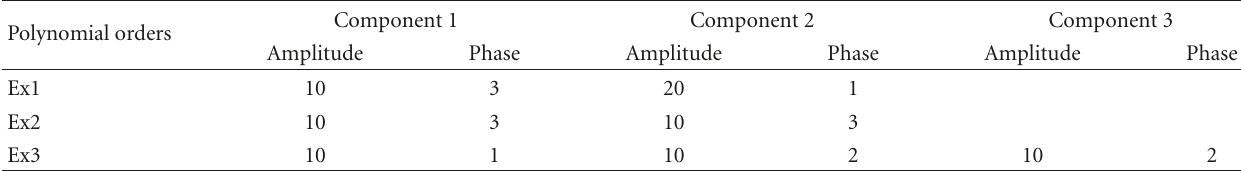
Table 6: Amplitude and phase orders for the